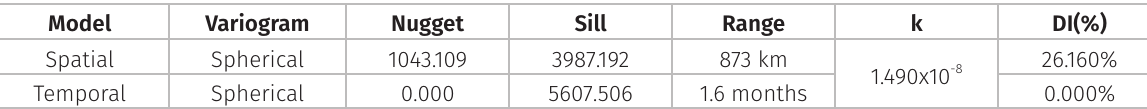
Table II. Estimates of parameters (Nugget, Sill, Range and k) in the generalized product-sum model and the spatial and temporal dependency index (DI) for the residuals of accumulated monthly rainfall of the São Francisco River Basin, Brazil. The parameter k represents the effect of the space-time interaction and contemplates the global sill.